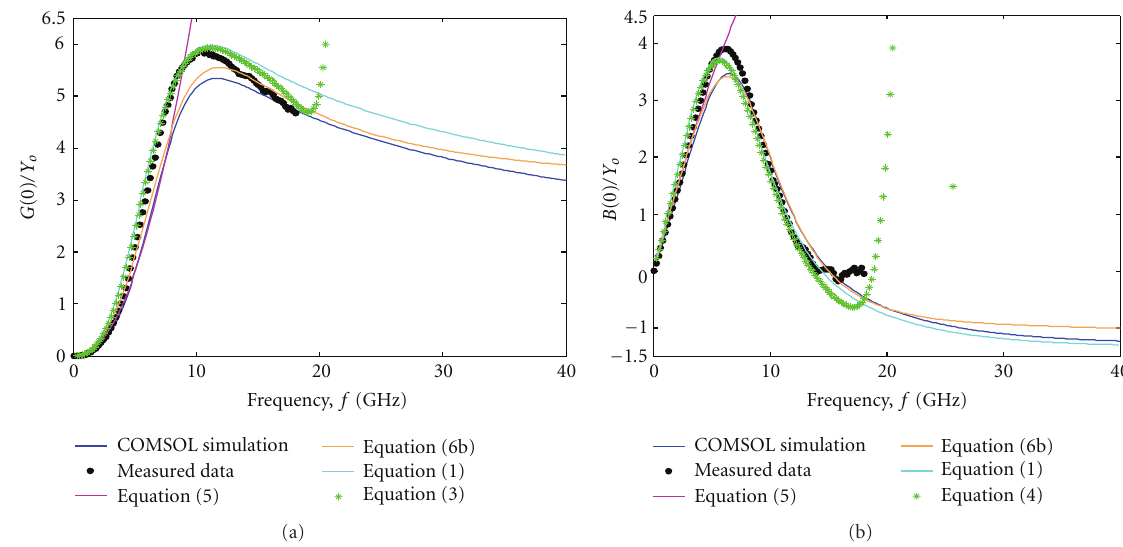
Figure 2: Comparison of (a) normalized conductance, G (0) /Y o , and (b) normalized susceptance, B (0) /Y o , for water at 25 ◦ C by considering size of probe with a = 0 . 65 mm and b = 2 . 05mm.